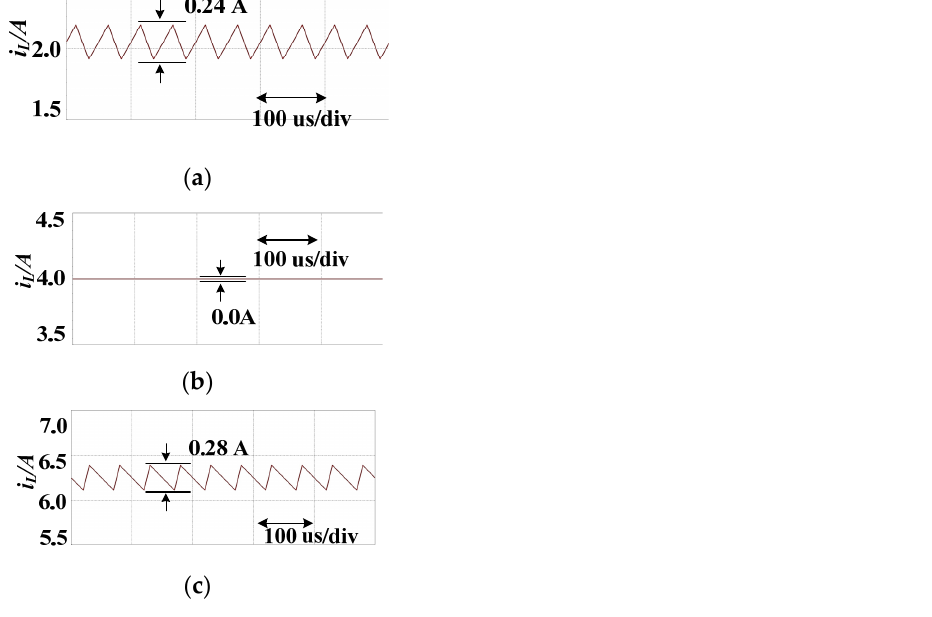
Figure 15. Simulated results of input current ripple characteristics of series circuit. ( a ) D = 0.3; ( b ) D = 0.5; ( c ) D = 0.6.